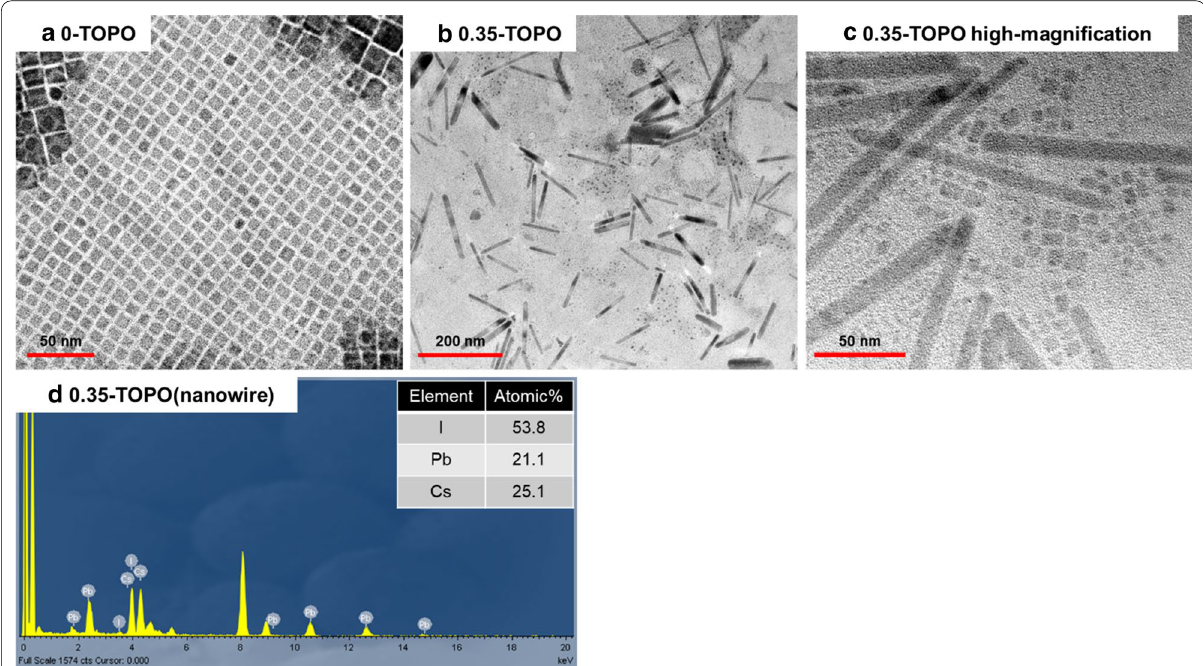
Fig. 5 High‑resolution TEM (HRTEM) micrographs of CsPbI 3 /TOPO composite solutions with different ratios: a 1:0, b 1:0.35, c 1:0.35 high‑magnification, d energy‑dispersive X‑ray (EDX) analysis for the nanowire in the CsPbI 3 /TOPO